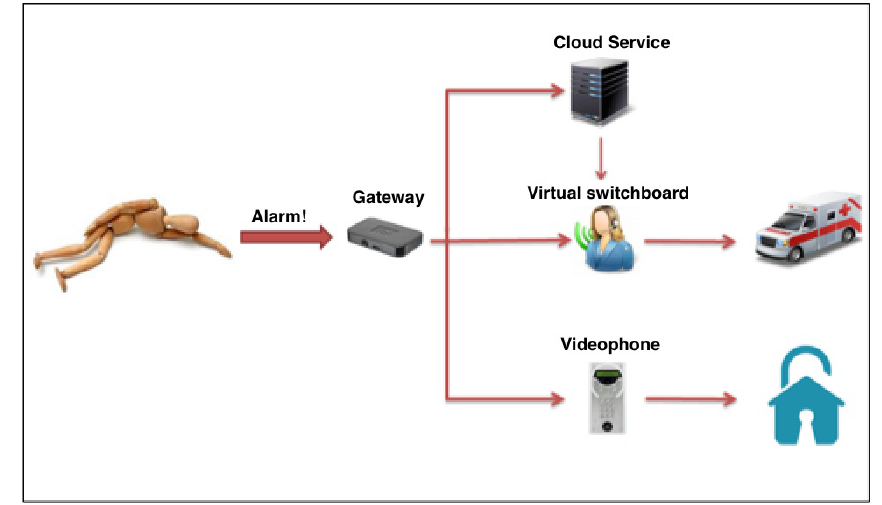
Figure 24. Example of possible HDOMO